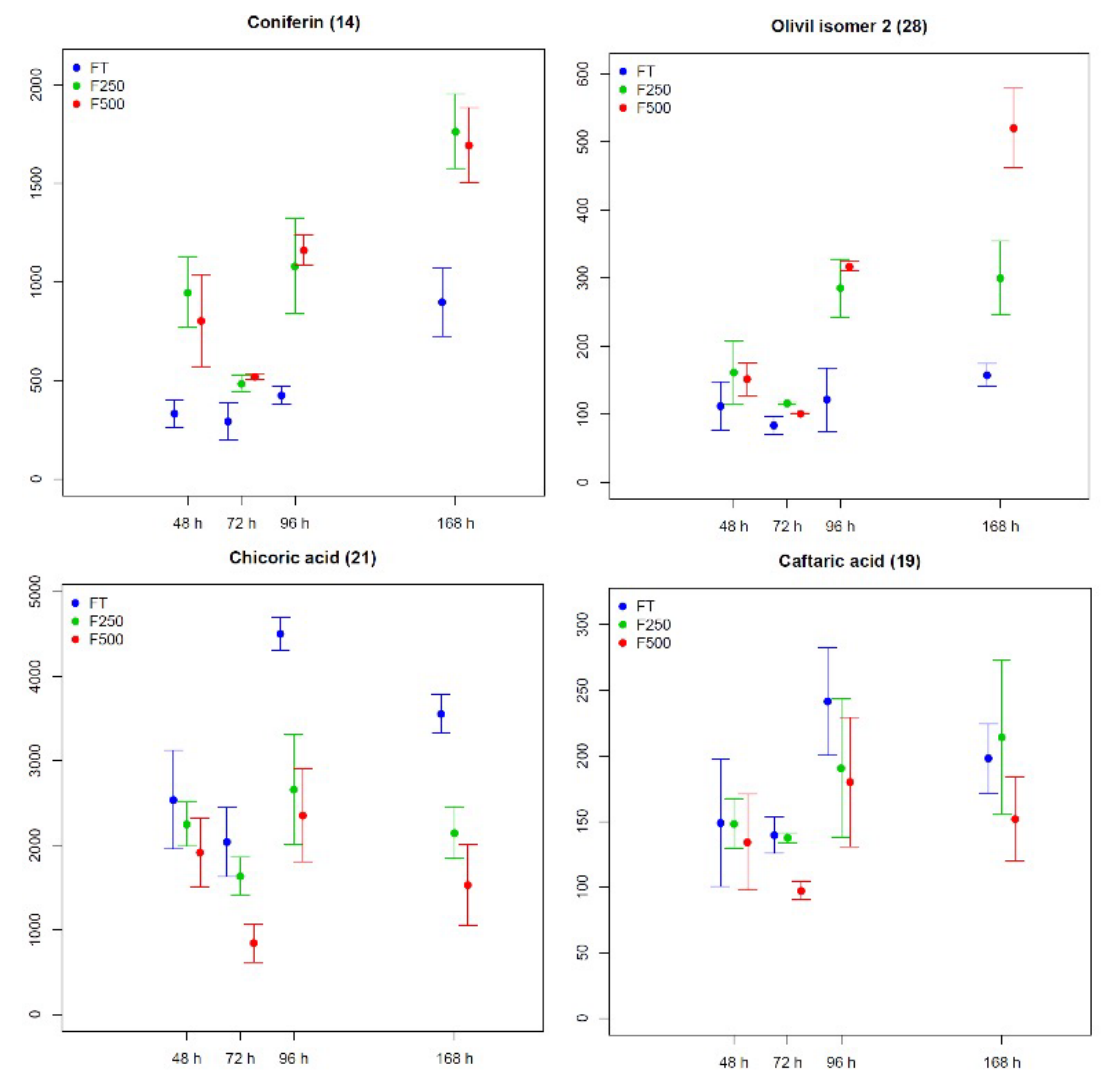
Figure A2. Comparison of some discriminating metabolite content in flax roots from control and seedling treated with COS oligosaccharides solutions (F250 and F500).